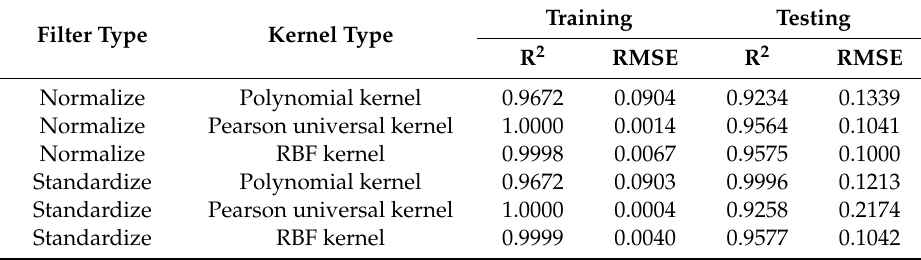
Table 10. Statistical results of drying kinetics of persimmon samples for SVM model using VD method.